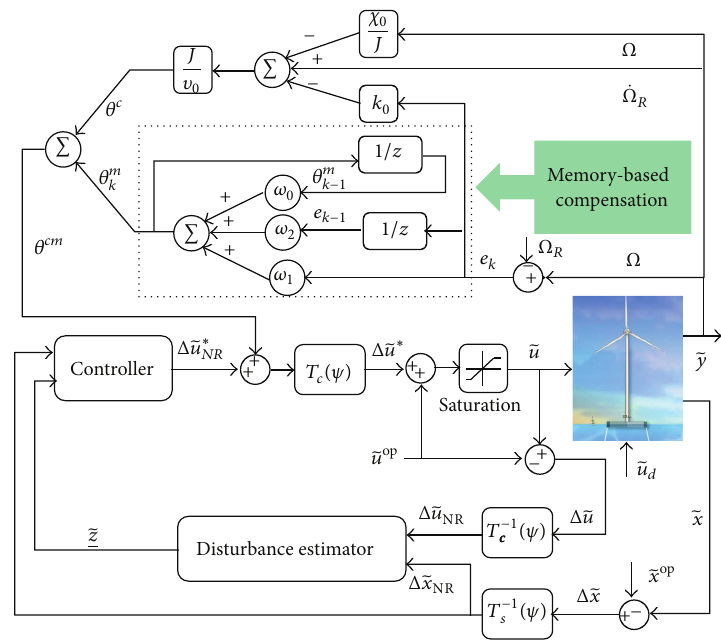
Figure 4: Block diagram of the overall control scheme.